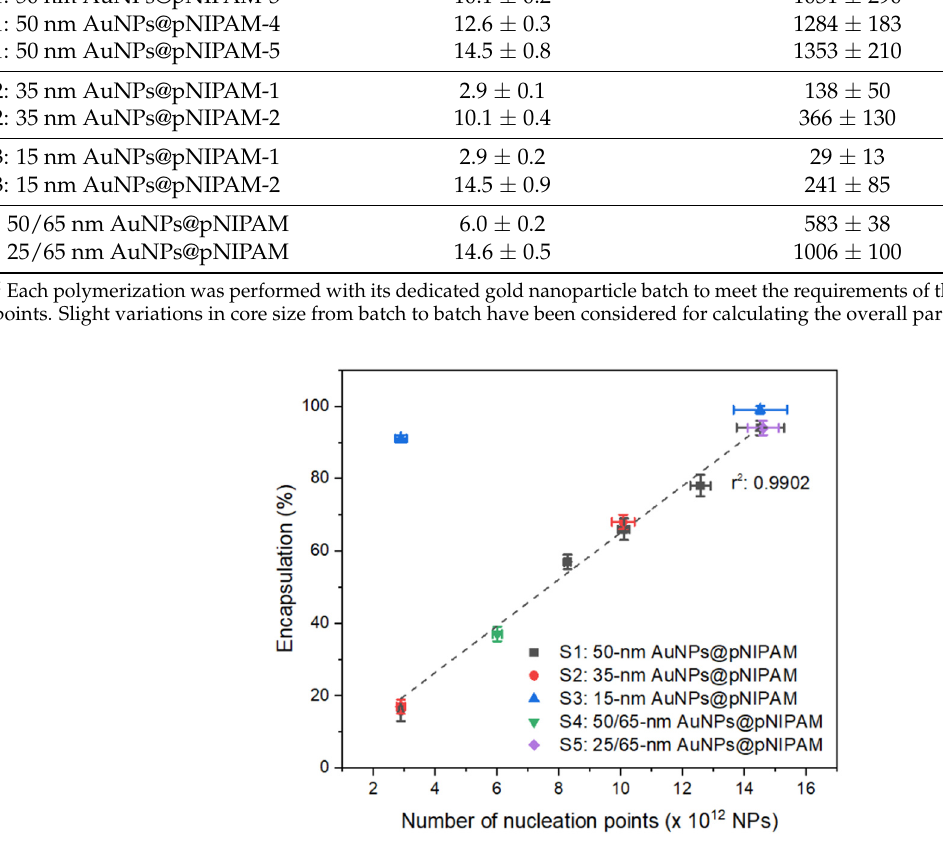
Figure 1. Successful gold cores encapsulation percentages as a function of the number of nucleation points used in the distinct polymerization experiments.